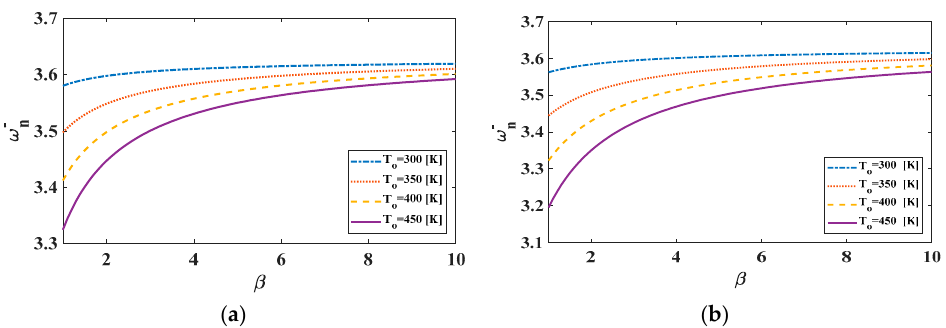
Figure 11. The e ff ect of di ff erent outer radius to inner radius ratios on the nondimensional natural frequency of MHCAP with clamp-clamp boundary conditions for di ff erent orientation angles of carbon fibers and h / b = 0.1, STR, T i = 273 [K], T o = 273 [K], W CNT = 0.02, V F = 0.2, FG-A, β = 1, K p = 10 [MN / m], and K w = 100 [MN / m 3 ]. ( a ) without elastic medium; ( b ) rested on Winkler medium; ( c ) rested on Winkler-Pasternak medium.